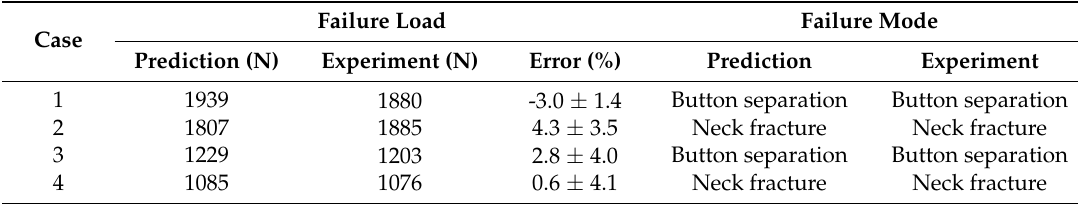
Table 4. Comparison of predicted and measured failure load and failure mode.